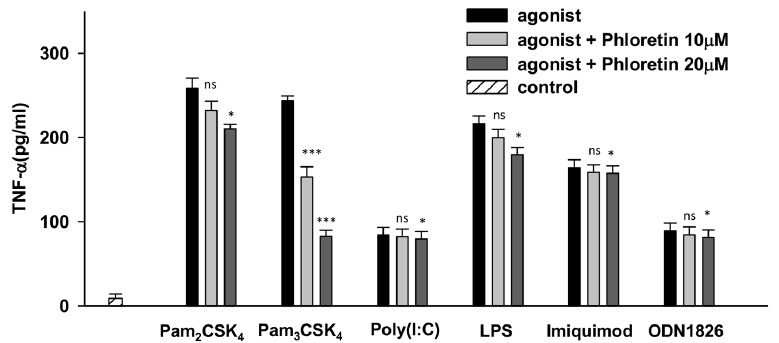
Figure 2. Specificity of phloretin with various TLR-specific agonists that selectively activate different TLRs determined by monitoring the inhibition activity of TNF- α production in Raw264.7 cells. Pam 3 CSK 4 (200 ng/mL), Pam 2 CSK 4 (200 ng/mL), poly(I:C) (1 µg/mL), LPS (20 ng/mL), imiquimod